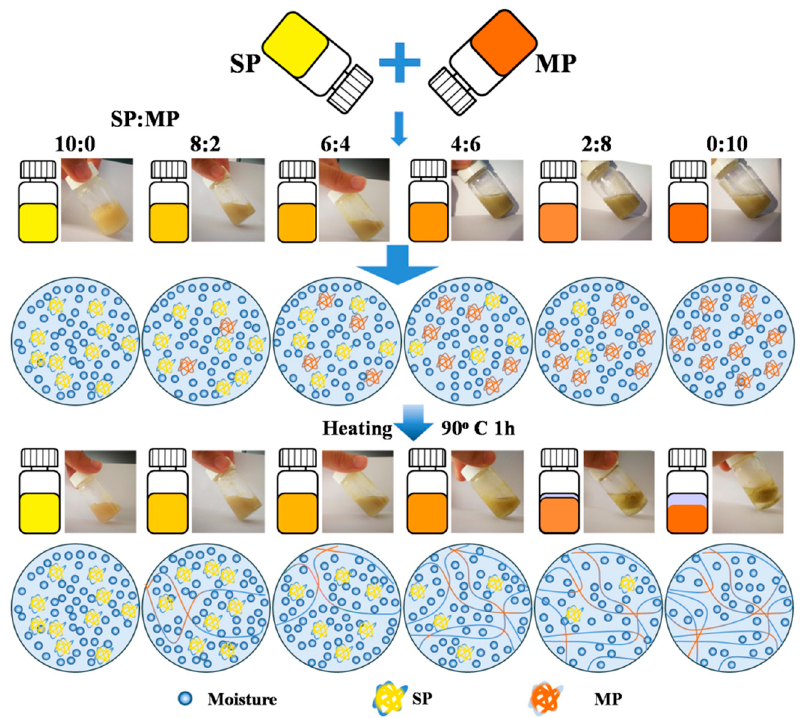
Scheme 1. Schematic illustration of preparing the double-protein gel with soy protein (SP) and myofibrillar protein (MP) before and after heating at 90 °C for 1 h.